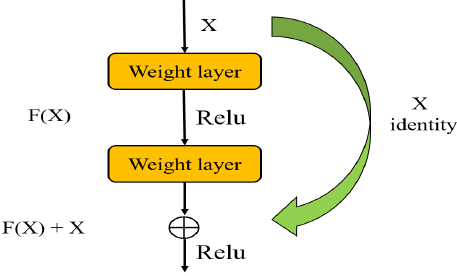
Figure 8. Simple residual block